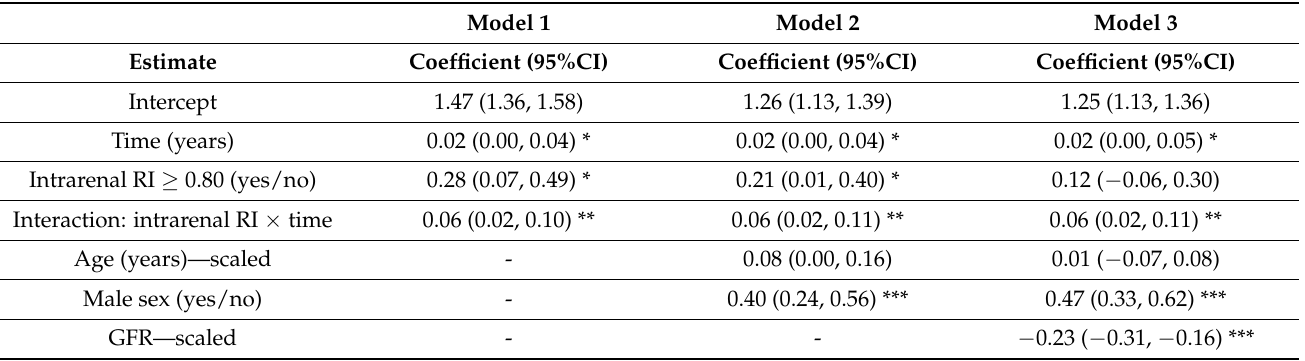
Table 3. Different models analyzed by mixed-effect linear regression of variables associated with serum creatinine levels change during follow-up.